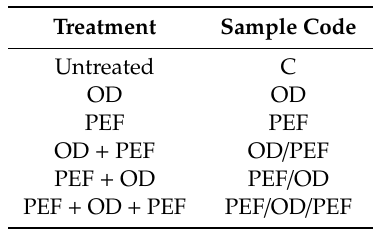
Table 1. Overview of the combination of treatments applied for kiwifruit slices at each drying temperature (50, 60 and 70 ◦ C) and relative sample codes.